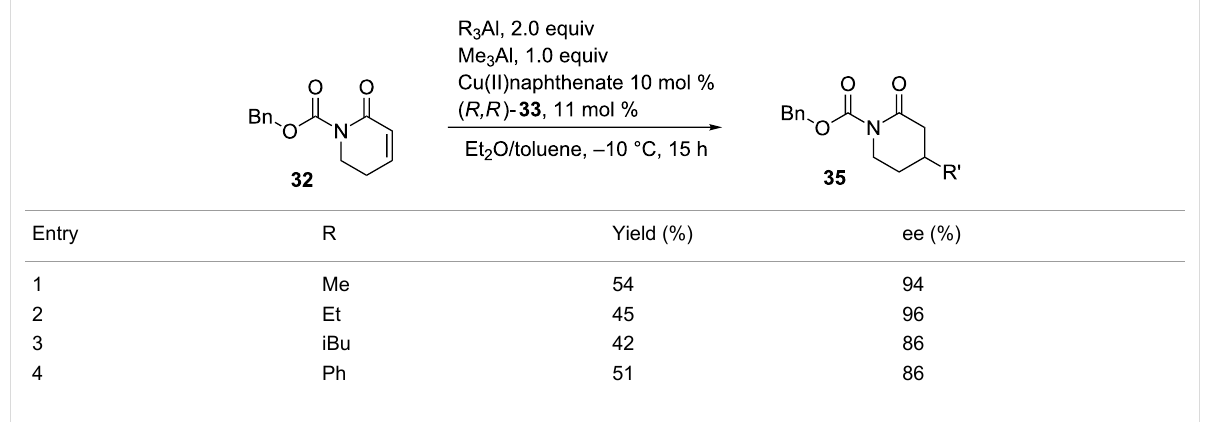
Table 3: Copper-catalyzed ECA reactions of alkylalane nucleophiles to an α , β -unsaturated lactam.